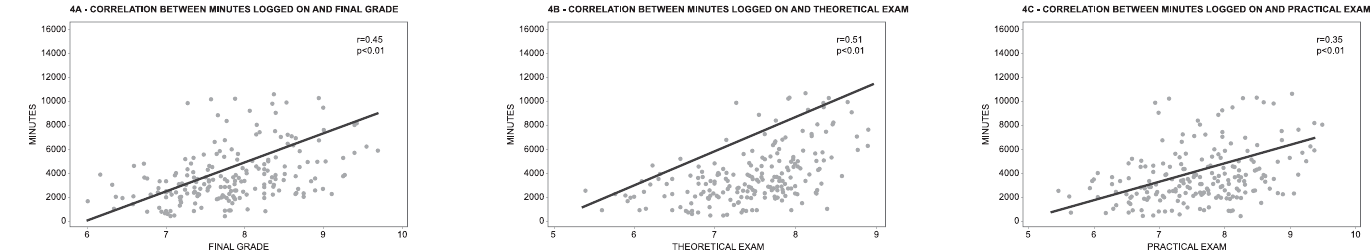
Fig 4. Correlations between number of hours logged on during the rotation period and final grade. 4A) Correlation between the number of hours logged per student during the rotation period and final grade in the discipline – Spearman coefficient = 0.45 (p < 0.01); 4B) Correlation between the number of hours logged on during the rotation period and the grade on the theory exam – Spearman coefficient = 0.51 (p < 0.01); 4C) Correlation between the number of hours logged on during the rotation period and the score on the practical exam — Spearman coefficient = 0.35 (p < 0.01).